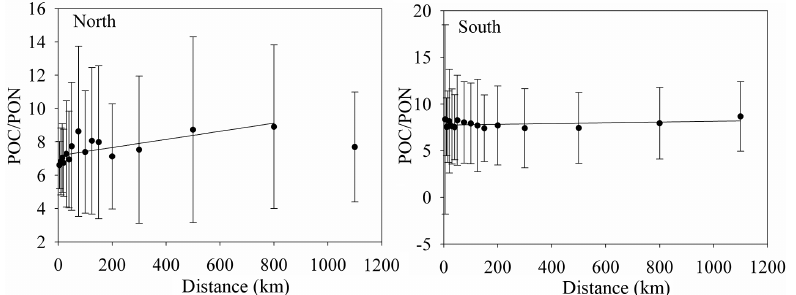
Figure 6. The variation of POC / PON with distance from the shore to the open sea. The relationships between POC / PON and distance are POC / PON = 0 . 0024 · D + 7 . 1764 ( R 2 = 0 . 519, Northern Hemisphere) and POC / PON = 0 . 0004 · D + 7 . 7346 ( R 2 = 0 . 118, Southern